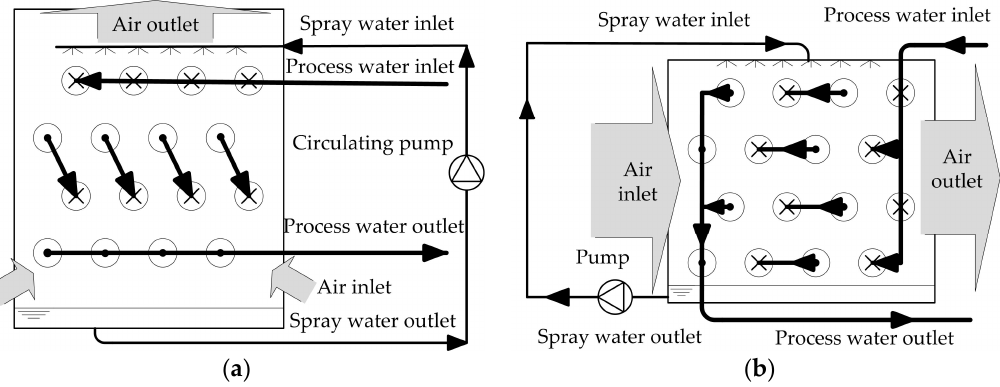
Figure 1. Schematic diagrams of the two typical counter-flow CWCTs with different constructions: ( a ) parallel counter-flow (PCFCWCT) and ( b ) cross counter-flow (CCFCWCT).